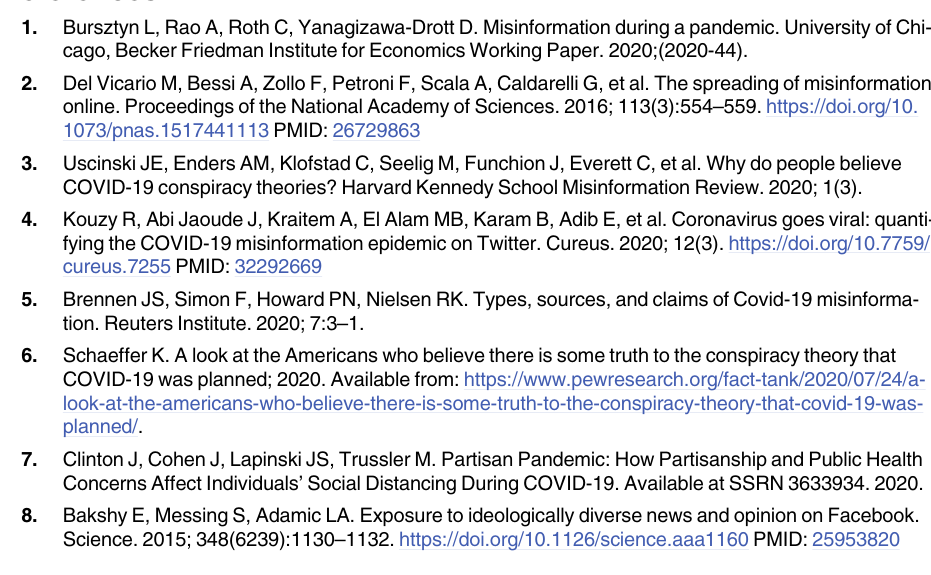
Baraba´si-Albert preferential attachment networks with N = 500, and added edges m = 3. Graphs show the percent of agents who believe B with strength b over time. Asterisks ( � ) denote these contagions had significant variance over simulation iterations. S22 Fig. Simple and proportional threshold contagion results on homophilic MAG net- works. Simple (top row) and proportional threshold (bottom row) contagion on a homophilic MAG networks with N = 500, and Θ detailed in Eq (8). Graphs show the percent of agents b who believe B with strength b over time. S23 Fig. Graphical contagion results for low correlation combinations across simulation run counts. Graphical results of contagion cascades across 10, 50, and 100 simulation runs for specific graph-message set combinations. Results displayed are those which yielded the lowest correlation scores between simulation run